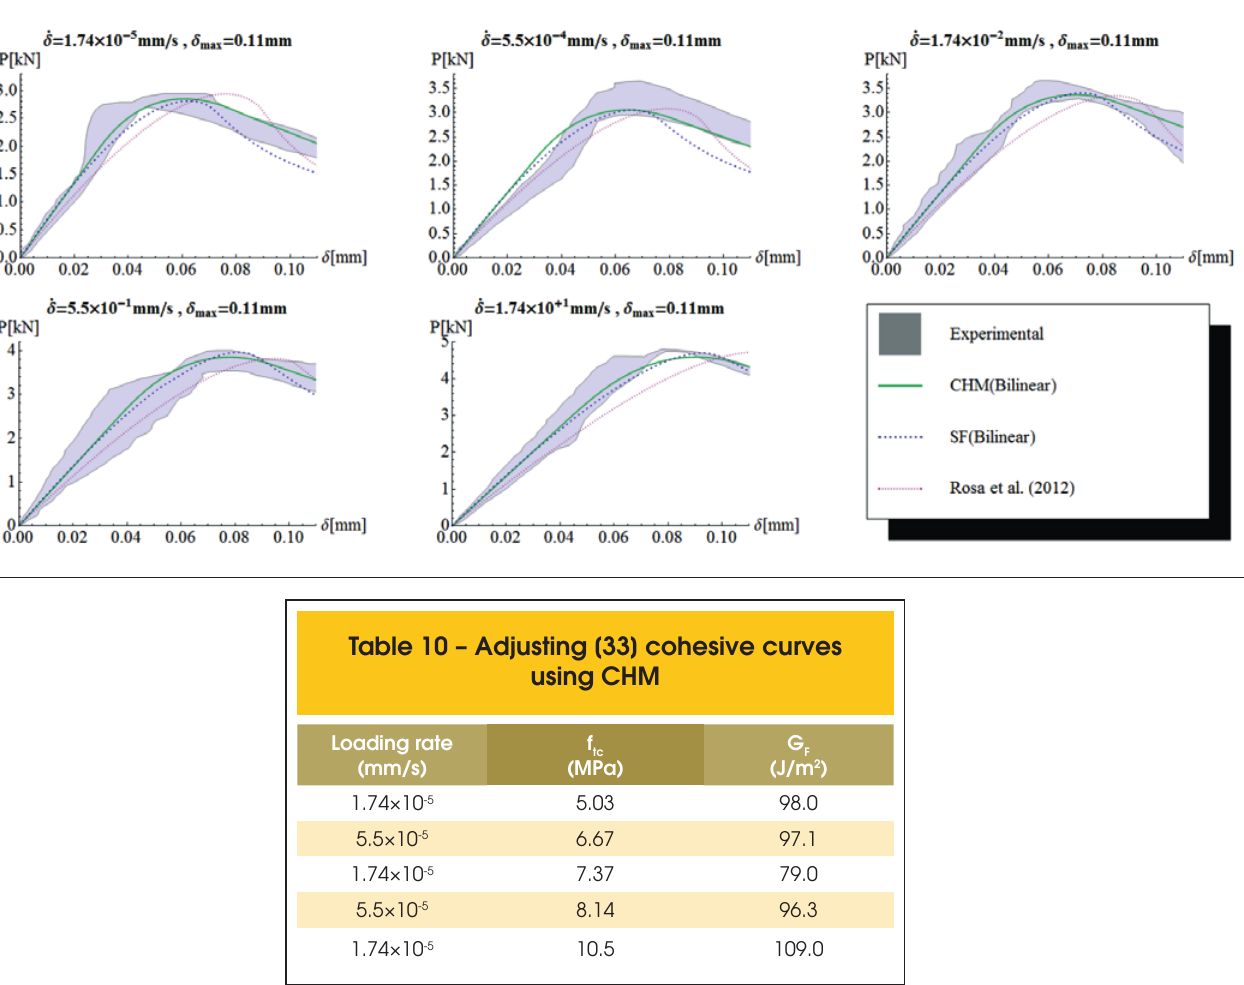
Figure 24 – curves for the range of 0 to 0.11 mm of simultaneously fit P- d of bilinear and viscous model